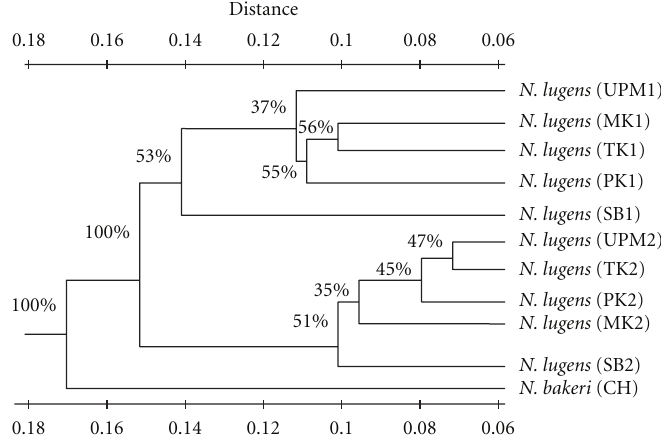
Figure 2: UPGMA dendrogram of the 11 populations of Nilaparvata spp. based on genetic distance from Dice’s index for DALP markers (Rice infesting population of N. lugens = UPM1, TK1, MK1, PK1, and SB1; Leersia -infesting population of N. lugens = UPM2, TK2, MK2, PK2, and SB2; an out group, N. bakeri = CH); bootstrap values from 1000 bootstraps are given at each fork. Table 4: Genetic distance matrix of the 11 populations of Nilaparvata spp. based on Nei and Li’s similarity index.